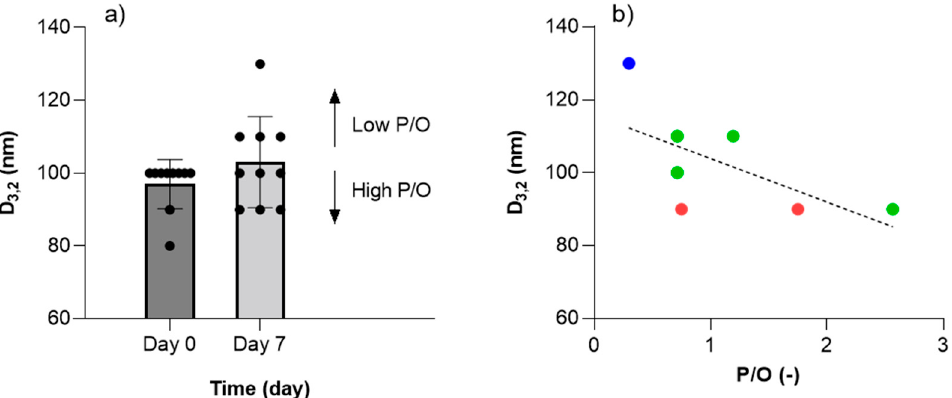
Figure 3. ( a ) Sauter mean diameter ( D 3,2 ) of nanoemulsions (<100 nm) as a function of time, and ( b ) ( D 3,2 ) at day 7 as a function of PPI-to-Oil ratio (P/O) and HPH pressure: 200 MPa (blue), 300 MPa (green), and 400 MPa (red).